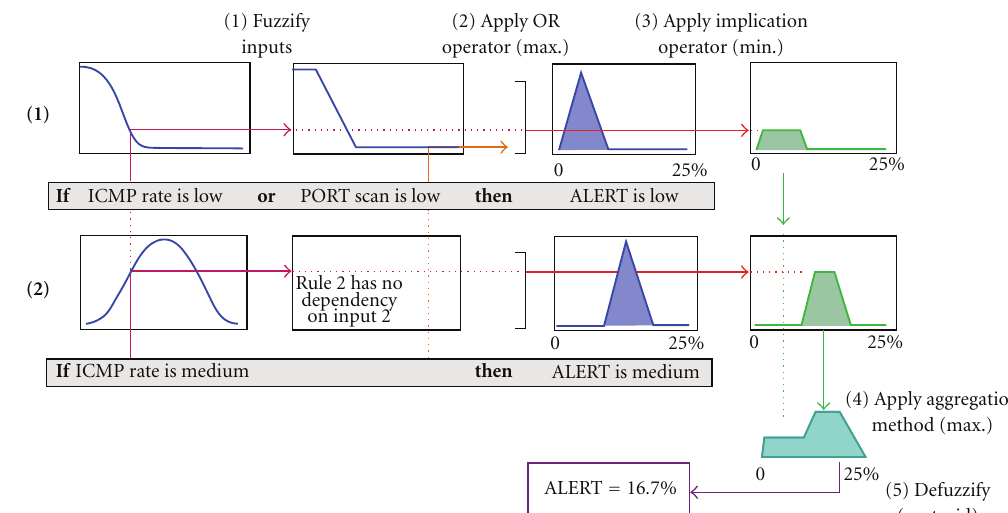
Figure 14: Fuzzy Logic example applied to